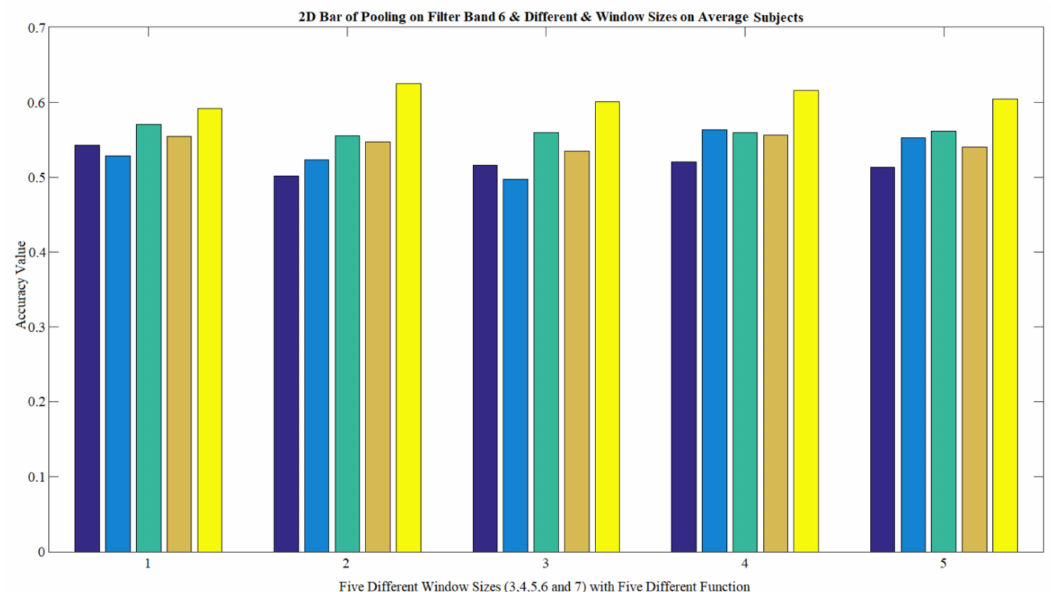
Figure 13. Reduction data based on pooling model on average subjects with filter banks with different window sizes for FB 6 and RF for 10